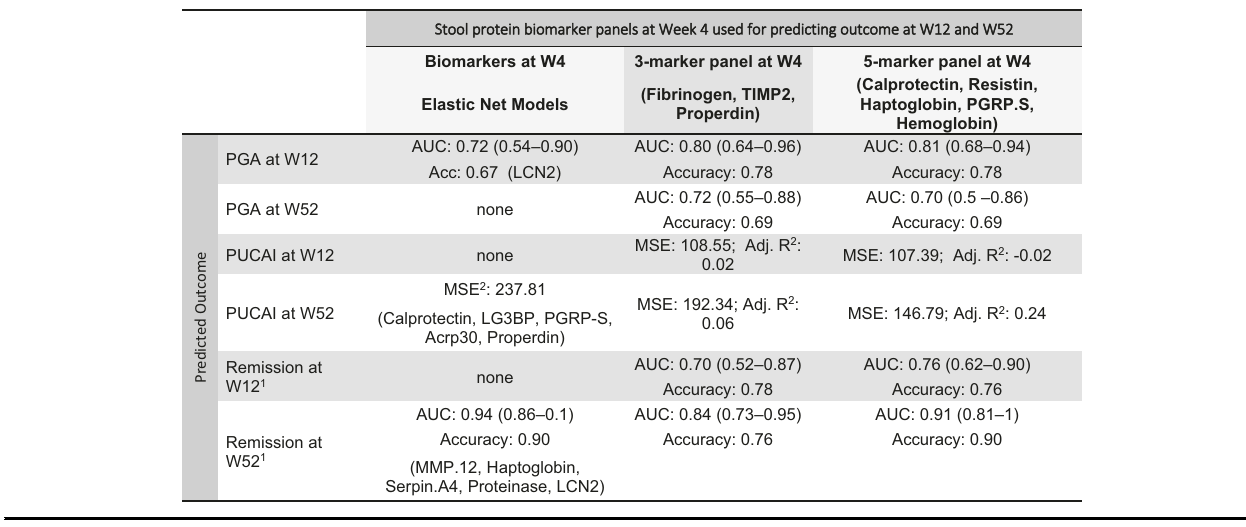
SStoolproteinbiomarkerpanelsatWeek4usedforpredictingoutcomeatW12andW52 Biomarkers at W4 3-marker panel at W4 5-marker panel at